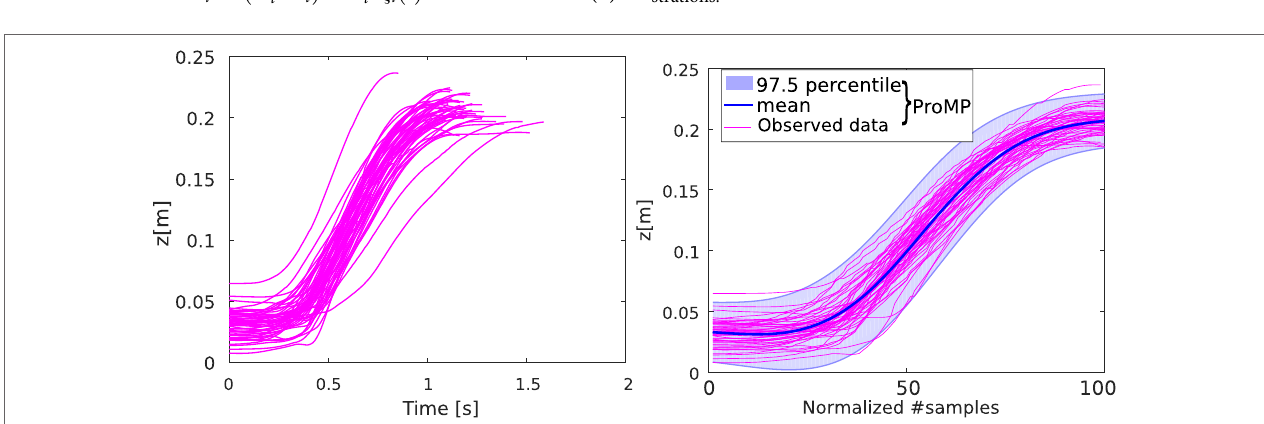
( ) = 1 the variance of the RBFs. M 2